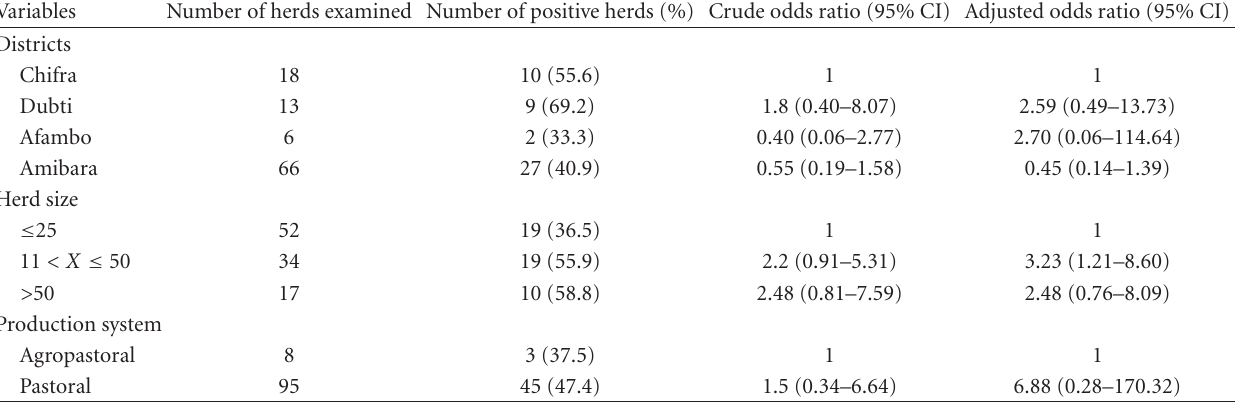
Table 3: Multivariable logistic regression analysis of herd TB positivity with selected risk factors at ≥ 2 mm cut-o ff point. Variables